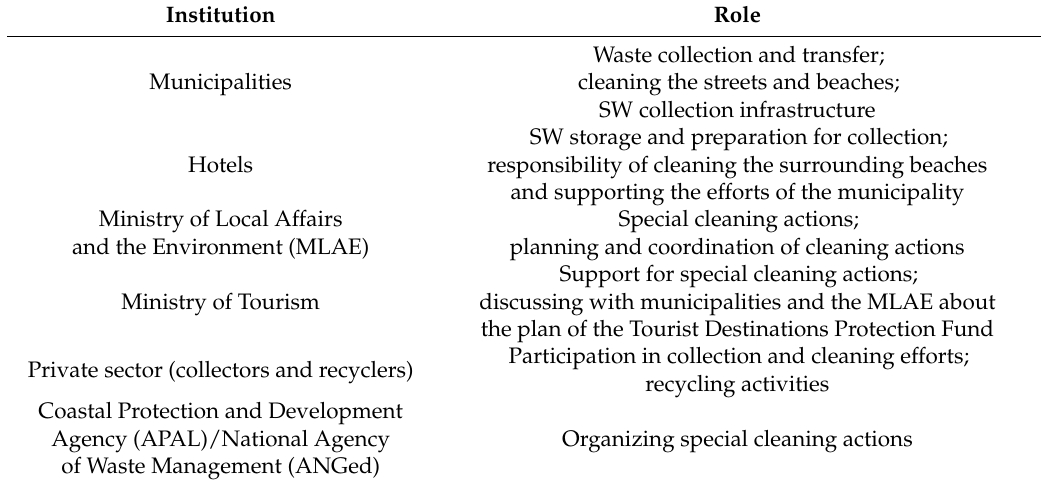
Table 3. Role of different stockholders in SWM in tourist